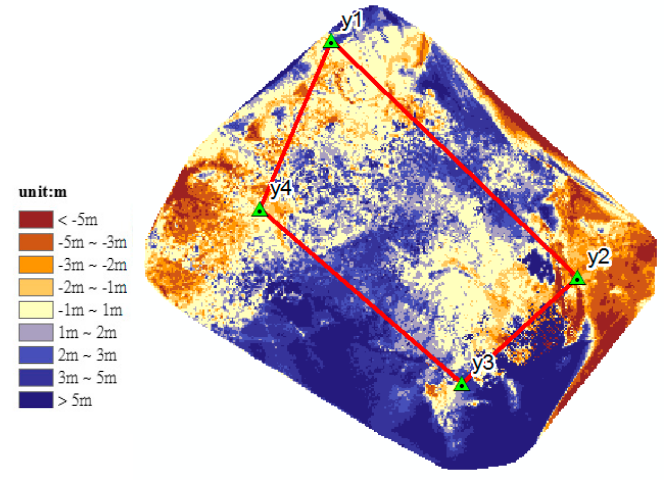
Figure 15. The illustration of quantitative analysis for thermal DSM (thermal DSM elevations minus LiDAR DSM). Table 5. The difference statistics between two DSMs generated from thermal images and airborne LiDAR.